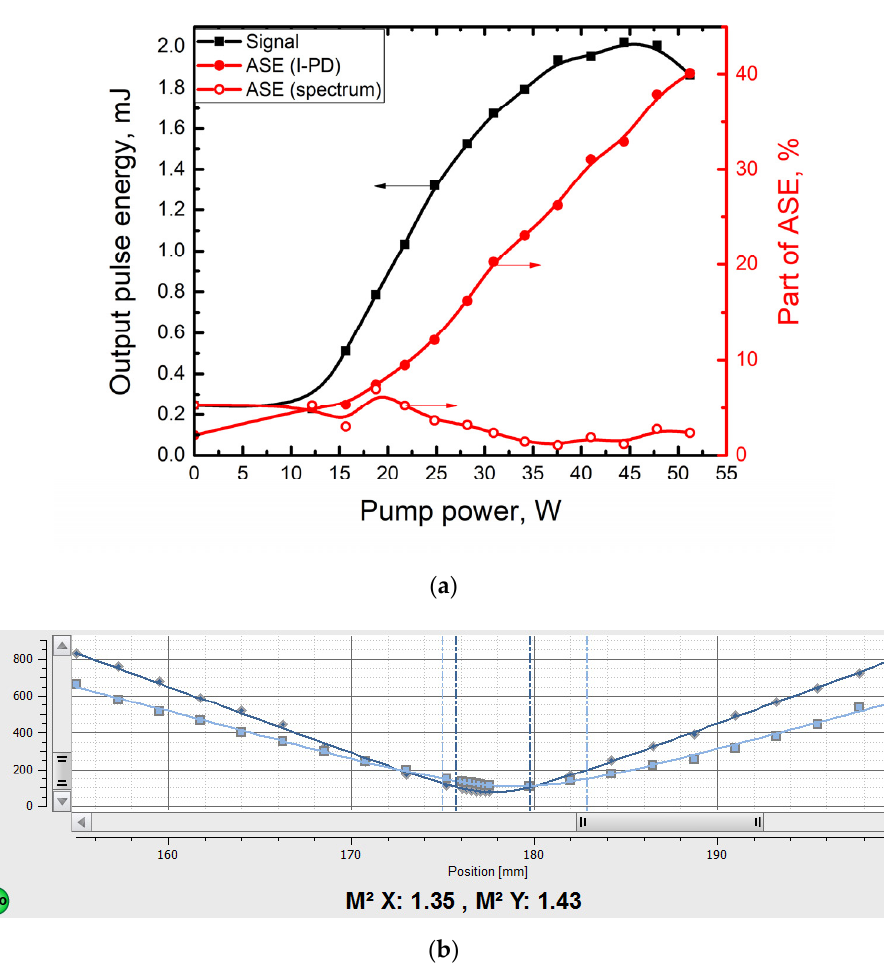
Figure 3. ( a ): dependence of the output energy and part of optical power propagated in ASE (measured by two methods) on the pump power; ( b ): measured beam quality factor at maximum pump power (51 W) in CW regime.